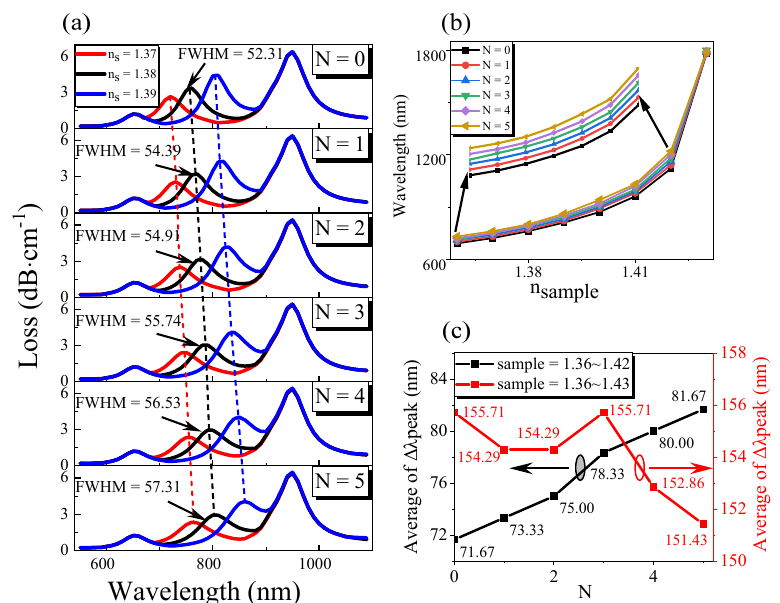
Figure 4. Optimization of graphene layer number of plasmonic optical fiber sensor under the condition of the same T, H and different refractive index of liquid to be measured: ( a ) The variation of transmission loss with wavelength under different graphene layers; ( b ) The change of resonance wavelength with the refractive index of the liquid to be measured under various layers of graphene; ( c ) The variation of the average resonant wavelength shift with the number of graphene layers under the different refractive index of the liquid to be measured.